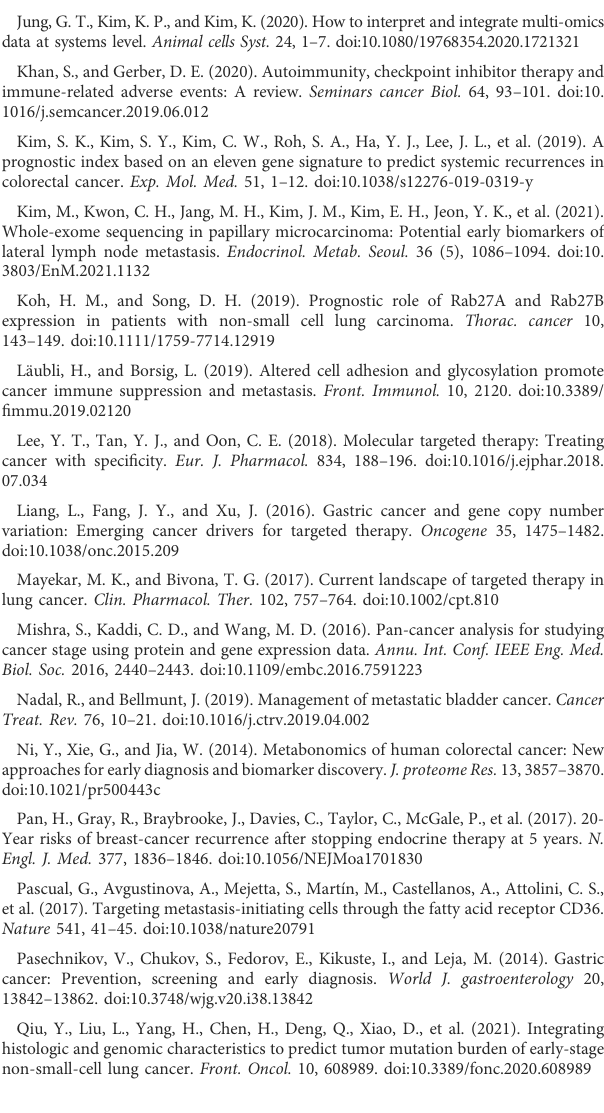
number variation rate, and different chromosomes were separated by dotted lines. The upper part of 0 indicated the copy number ampli fi cation rate, which was the sum of the low-level copy number ampli fi cation rate in light yellow and the high-level copy number ampli fi cation rate in dark yellow. The lower part of 0 indicated the copy number deletion rate, which was zero minus its true. The mutation rate is the sum of the single-copy deletionrateinlightgreenandthehomozygousdeletionrateindarkgreen. SUPPLEMENTARY FIGURE S5 (A) : Comparing the recurrent tumor with the primary tumor, the heatmap of log 2 FC values of genes related to four cell state. (B) : Comparing the metastatic tumor with the primary tumor, the heatmap of log 2 FC values of genes related to six cell